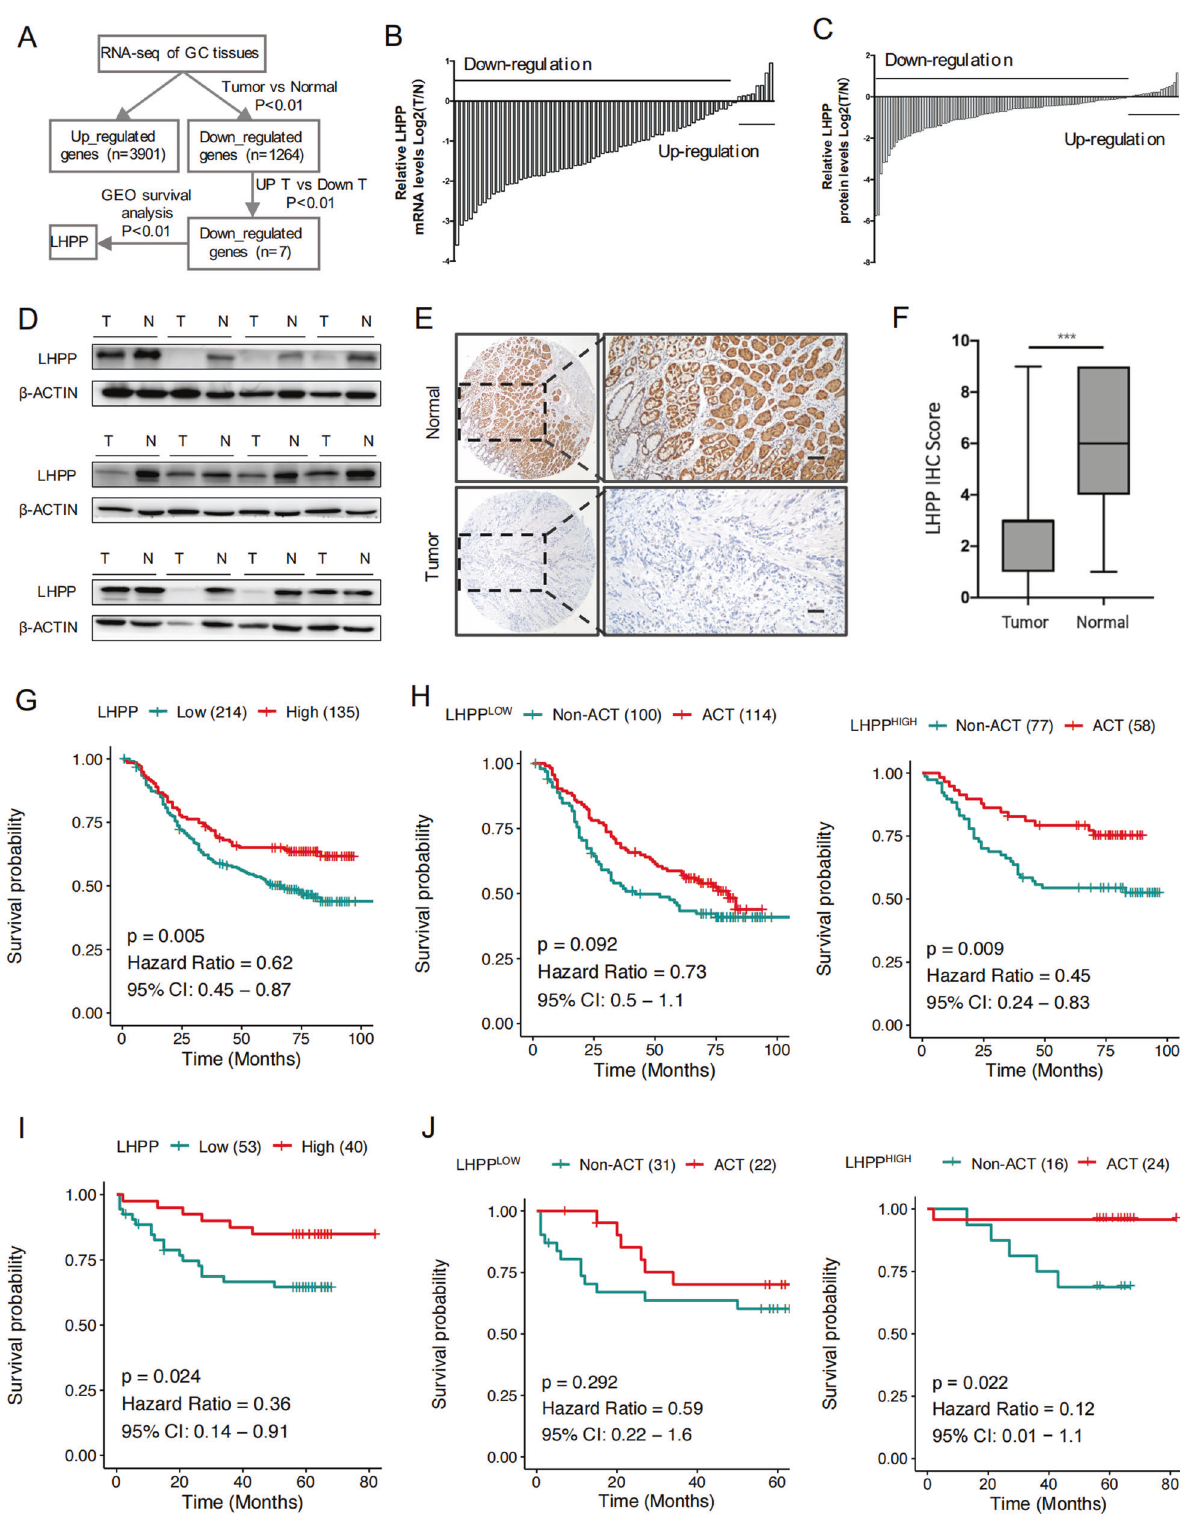
patients with GC and combined it with the GEO database ( fi ve datasets GSE14210, GSE15459, GSE22377, GSE29272 and GSE51105 are combined, total number of cases = 592) for survival analysis to screen out the downregulated LHPP gene (Fig. 1A and Supplementary Fig. 1, 2). In the TCGA database, we found that the